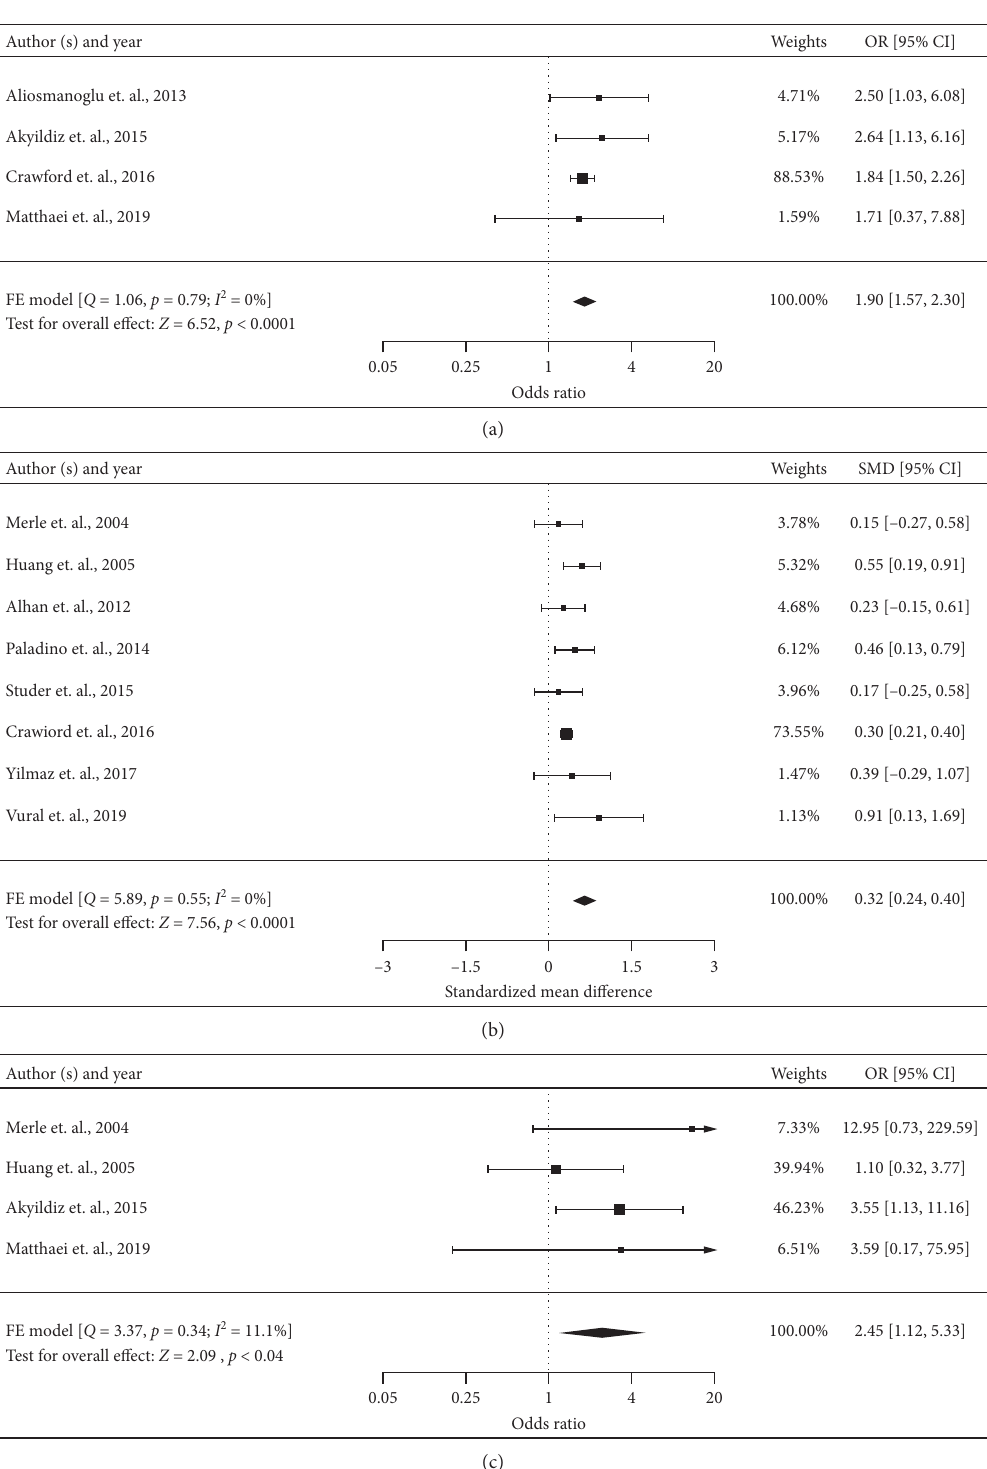
Figure 2: Forest plots for significant preoperative risk factors for short-term postoperative mortality of AMI after laparotomy with data available in at least four studies (demographics and etiology). AOMI: arterial occlusive mesenteric ischemia; FE: fixed effect; MVT: mesenteric venous thrombosis; RE: random effect. (a) Old age (categorical variable), (b) age (continuous variable), and (c) AOMI versus MVT (categorical